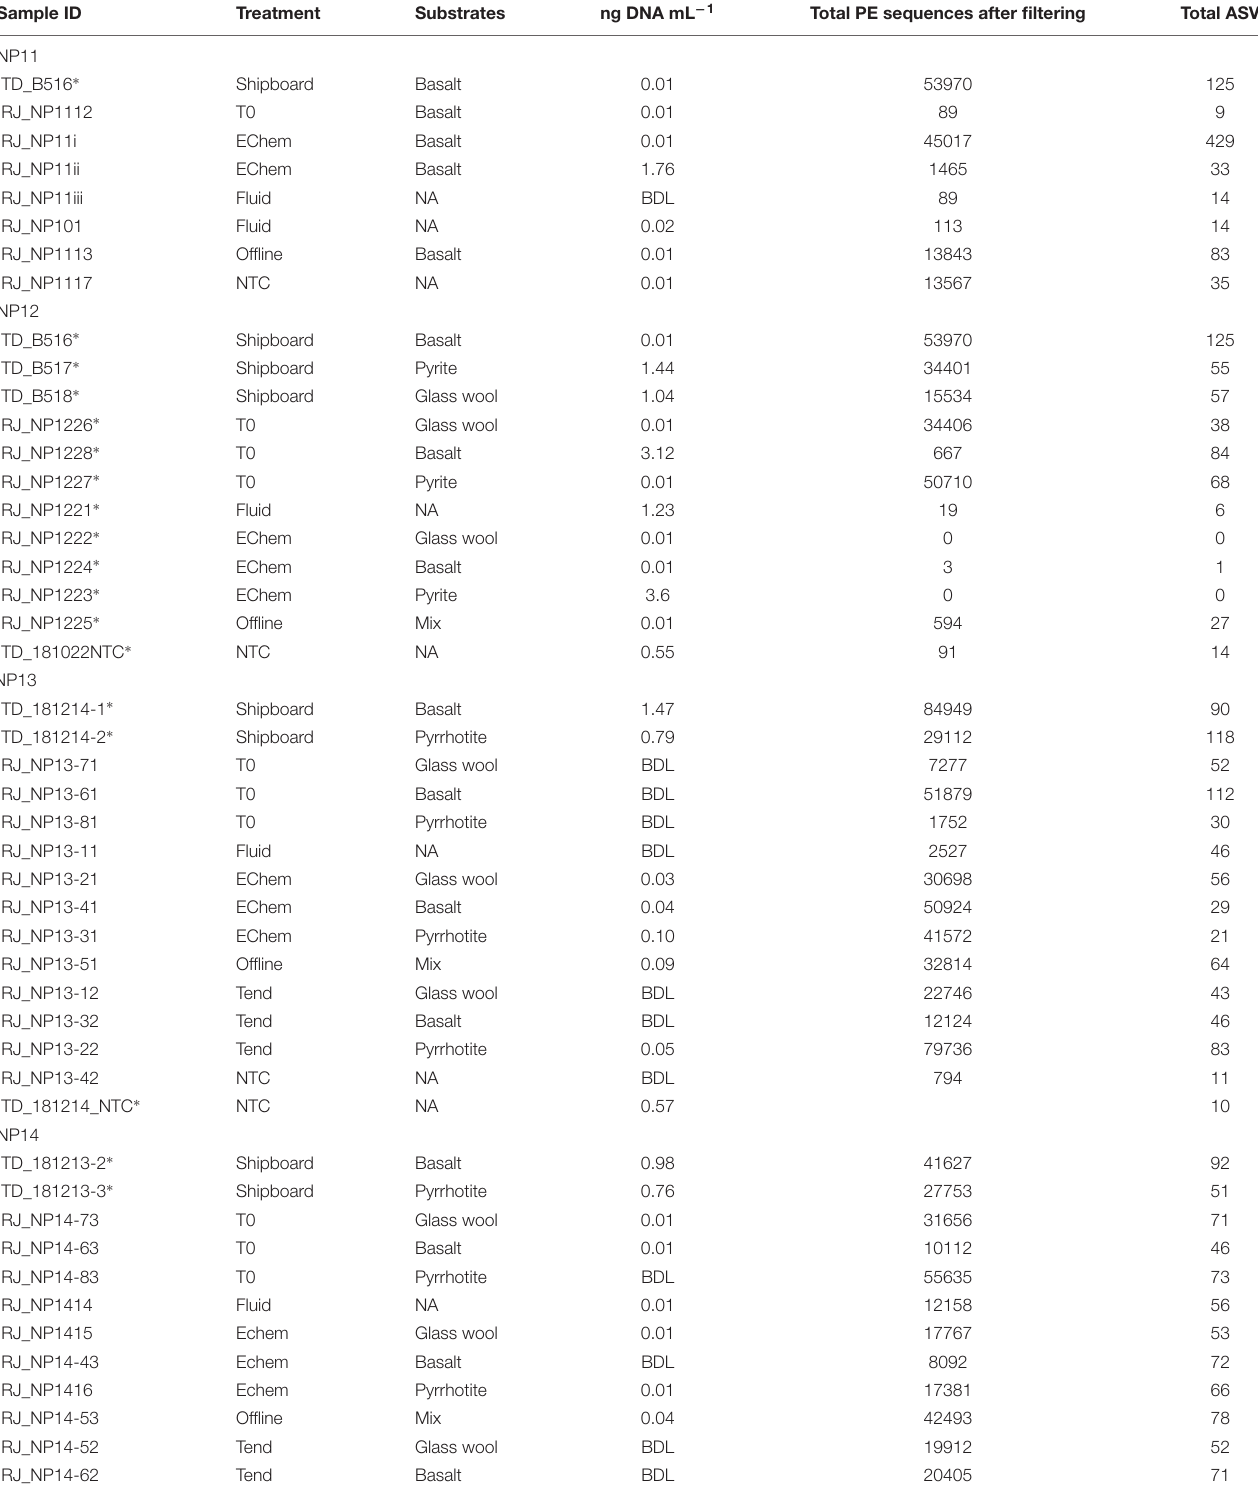
TABLE 3 | Summary of DNA extractions and 16S rRNA gene amplicon sequence analysis (after quality control filtering) for each experiment and treatment, including in the original samples after collection and direct preservation on the ship (shipboard or SB), at the start of the experiment after 1 + year of sample storage (T0), on the ITO electrode at the end of the experiment (EChem), on the sample material in the WE cell at the end of the experiment (Tend), in an electrochemical cell with only sterile fluid (Fluid), in an electrochemical cell without voltage applied (Offline), and in a no template negative DNA extraction controls run with the same batch of samples